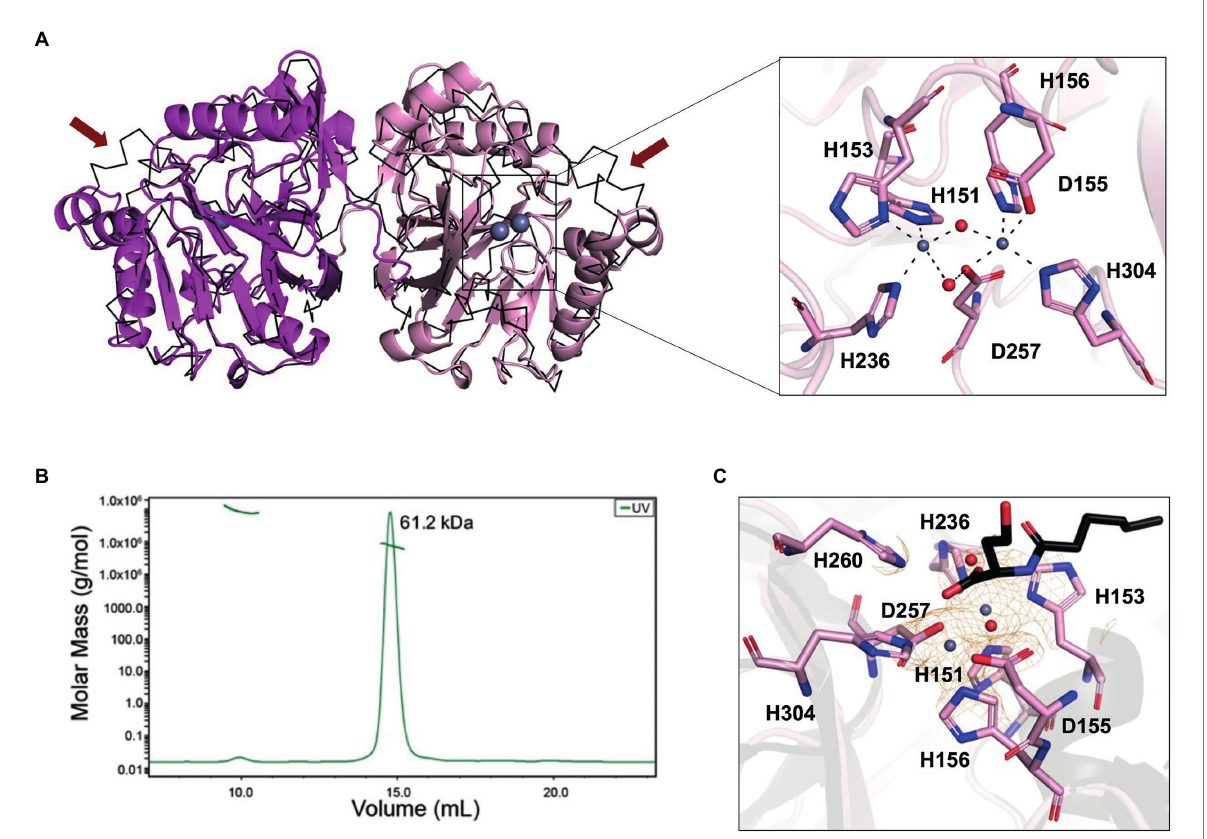
FIGURE 2 Structural analysis of LrsL. (A) Dimeric crystal structure of LrsL. ( Left ) The structure of LrsL (residue 49 to C-terminal) is shown as cartoon diagram, with one chain in magenta and the other chain in light pink. The C-alpha trace (black) of the experimental structure of the AidC dimer (PDB accession 4zo3) is superimposed. The two zinc ions included in each LrsL protein chain are shown in blue-gray. ( Right ) Zoom into the zinc- binding active site binding pocket of LrsL. The zinc-coordinating residues as highlighted in Figure 1A and Supplementary Figure S2 are marked as light pink sticks. Zinc ions are shown as blue-gray spheres. Zinc coordinating atoms are indicated by dashed lines from the atom to zinc. The red spheres indicate water molecules that contribute to zinc coordination in LrsL. (B) Size Exclusion Chromatography coupled with Multiangle Light Scattering (SEC-MALS) analysis showed that LrsL eluted as a single peak with a molecular weight of 60.2 kDa, corresponding to the molecular weight of an LrsL dimer. (C) 2 F o - F c map (orange mesh) for the unliganded LrsL zinc ions and water molecules. The map is contoured at 2 σ . The LrsL zinc-binding site is superimposed on the crystal structure of AidC:C6L complex (PDB 4zo3), showing electron density close to the C6L O1 atom in the AidC-C6L complex structure (C6L is shown as a stick model with carbon atoms in black). Residue coloring corresponds to the right panel in (A)